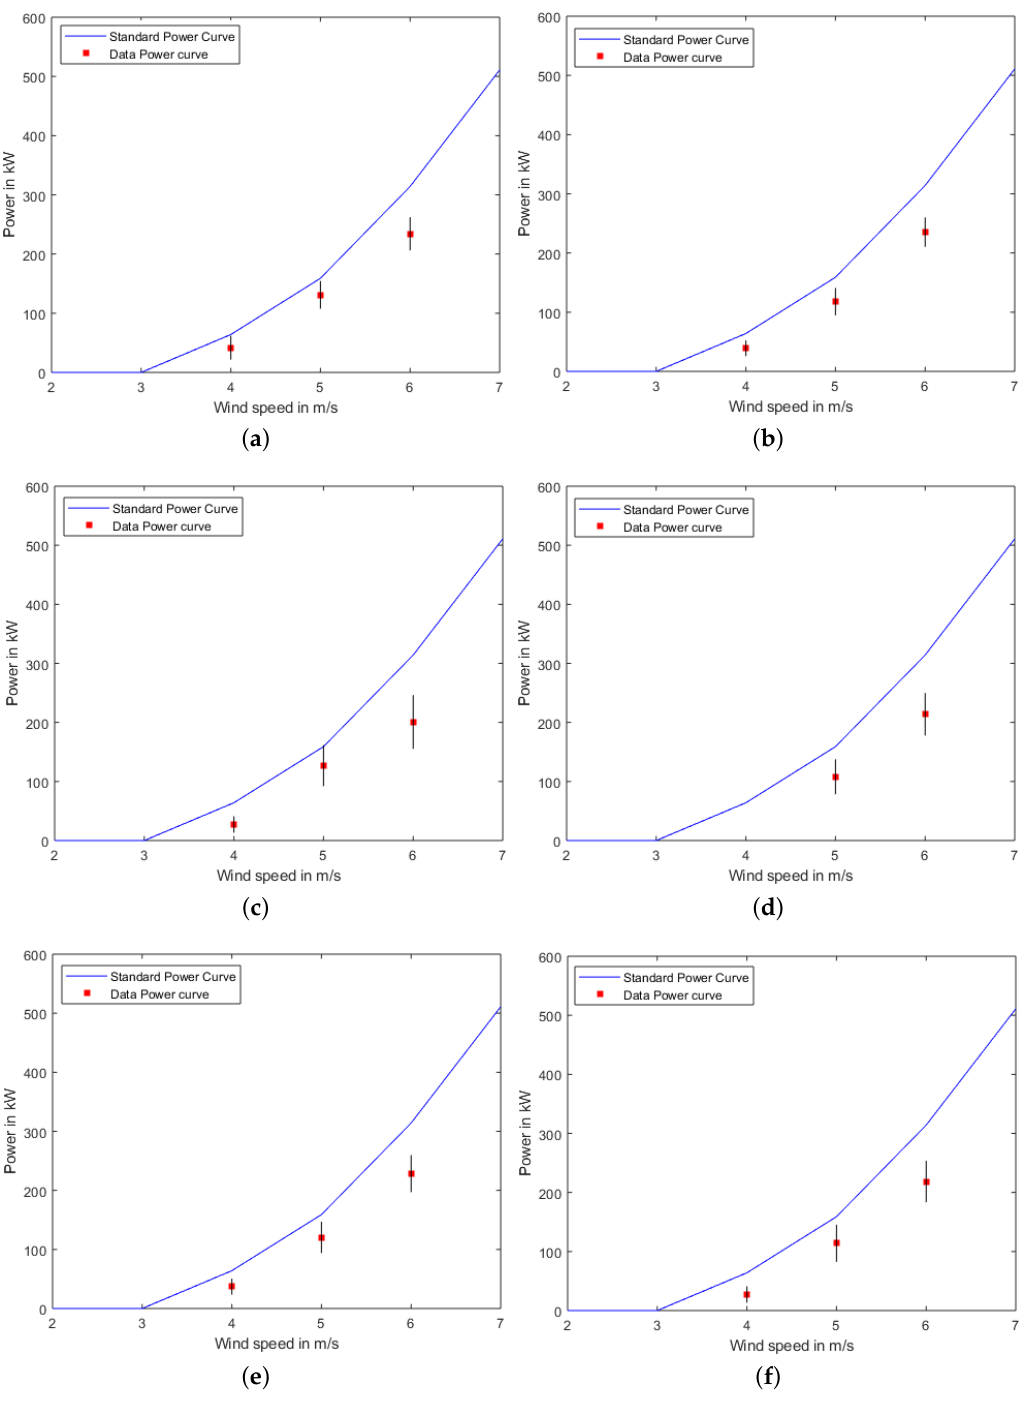
Figure 7. SMV6 production in yawed conditions with standard deviations ( a ) 0 ◦ ± 5 ◦ ; ( b ) 5 ◦ to 10 ◦ and − 5 ◦ to − 10 ◦ ; ( c ) 10 ◦ to 15 ◦ and − 10 ◦ to − 15 ◦ ; ( d ) ≤ 15 or ≥ − 15; ( e ) 5 ◦ to 15 ◦ and − 5 ◦ to − 15 ◦ ; ( f ) 10 ◦ to 20 ◦ and − 10 ◦ to − 20 ◦